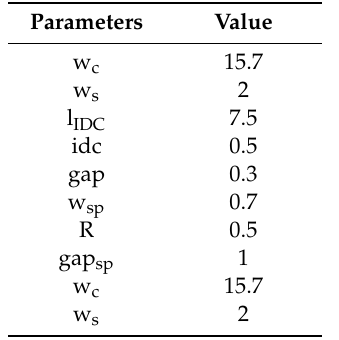
Figure 11. Designed CRLH transmission line antenna. Table 3. Parameters of the CRLH TL unit cell.